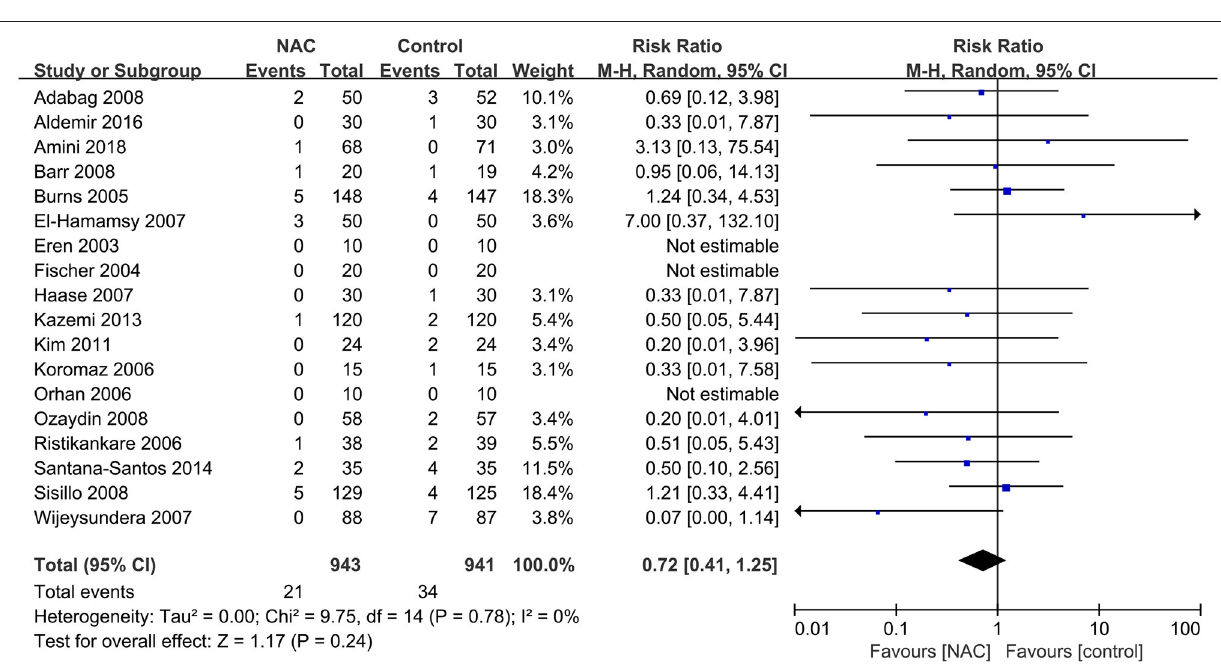
FIGURE 5 | Forest plot of the effects of NAC on the incidence of all-cause